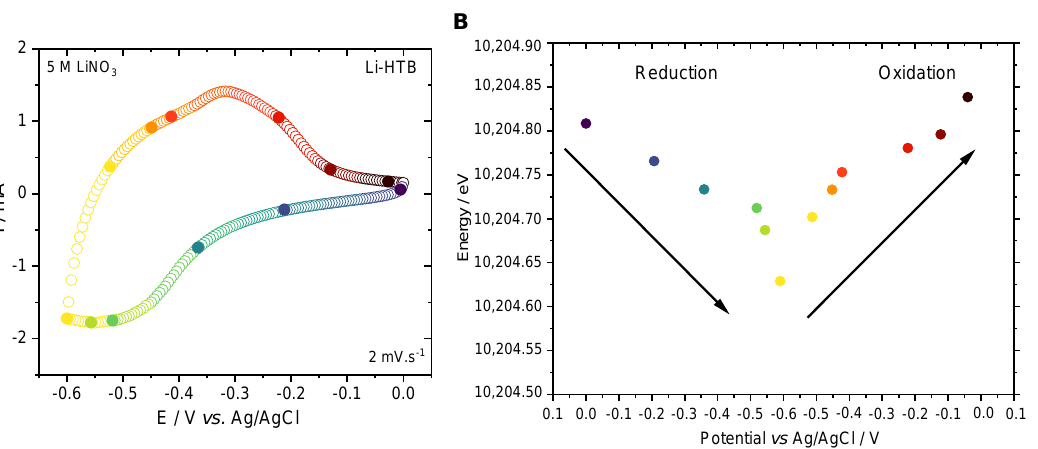
Figure 6. ( A ) Cyclic voltammogram for Li-HTB at 2 mV.s − 1 in 5 M LiNO 3 (the colored dots represent the XAS spectra acquisition selected for this representation). ( B ) Evolution of the W L 3 -edge energy position as a function of the sweep of potential vs. Ag/AgCl.